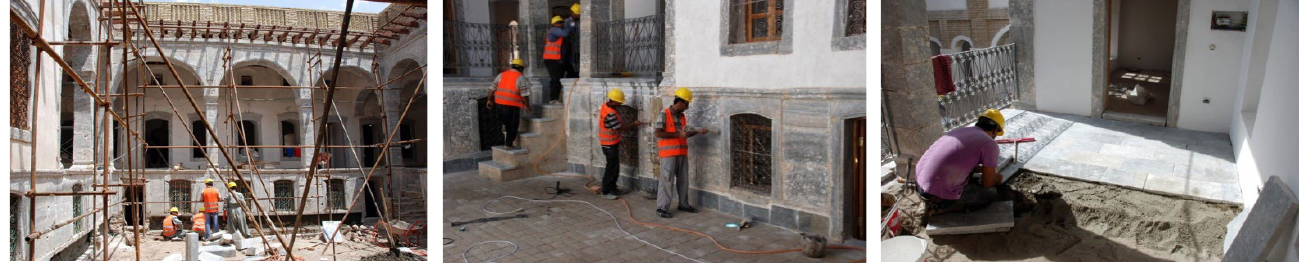
Figure 12. Renovation of Shihab Chalabi house [137].